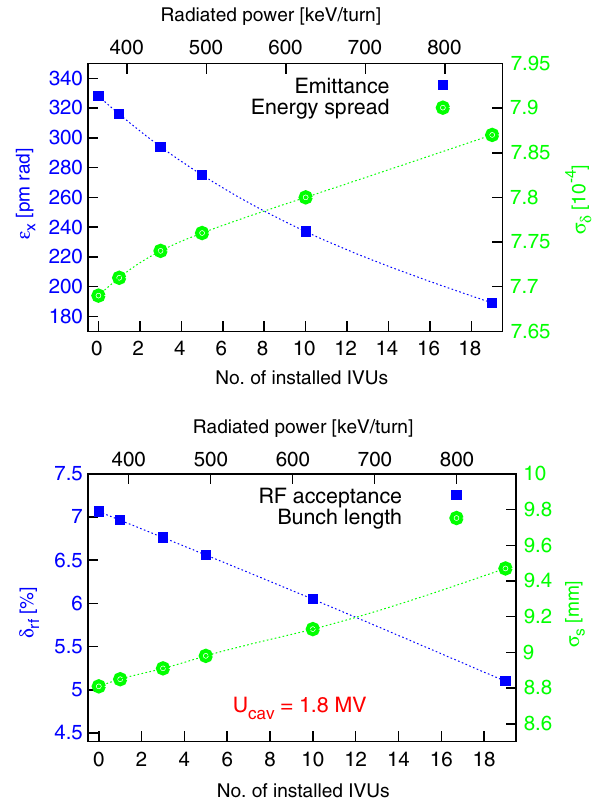
FIG. 1. Beam parameters of the MAX IV 3 GeV storage ring as a function of the number of installed IVUs (for details cf. Sec. II). At fully closed gap each IVU adds 26 keV = turn to the synchro- tron radiation losses. Top: zero-current emittance and natural energy spread. Bottom: rf acceptance and zero-current bunch length assuming 1.8 MV overall cavity voltage.